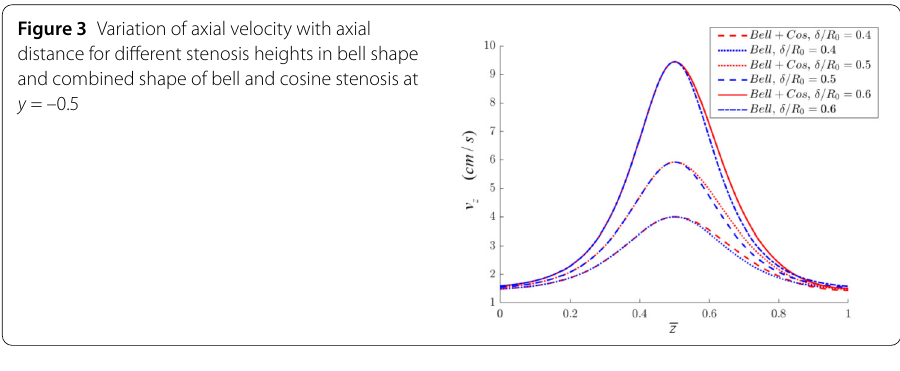
Figure 4 Variation of axial velocity with radial distance for different stenosis heights in cosine shape and combined shape of cosine and bell stenosis at ¯ z =